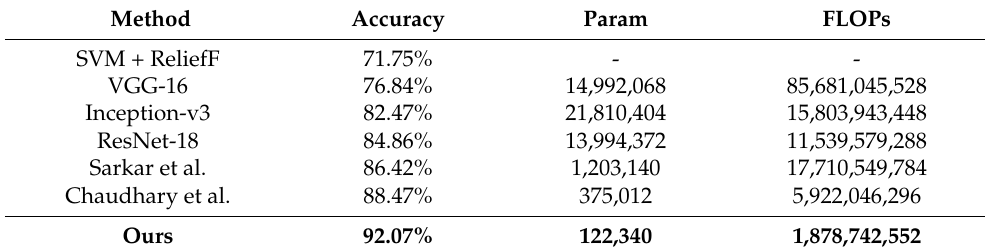
Table 6. On 4Q emotion datasets, the result present as bold.